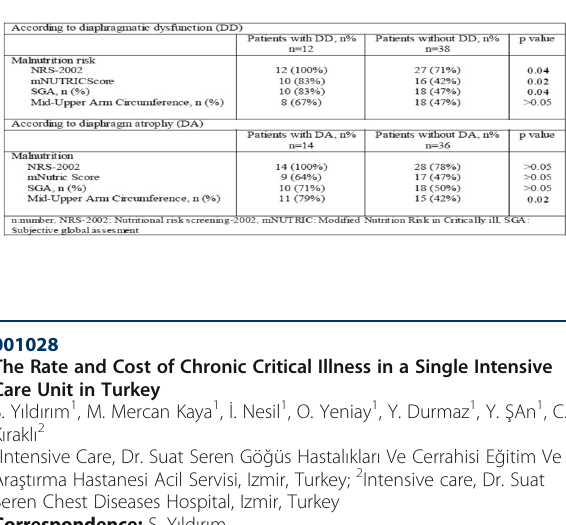
Table 1 (abstract 001022). Relationship between diaphragmatic measurements and malnutrition risk in medical ICU patients